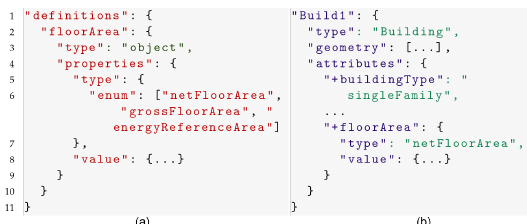
Figure 6. New data types and enumerations (a) defined in the Extension schema, (b) used in a CityJSON file.